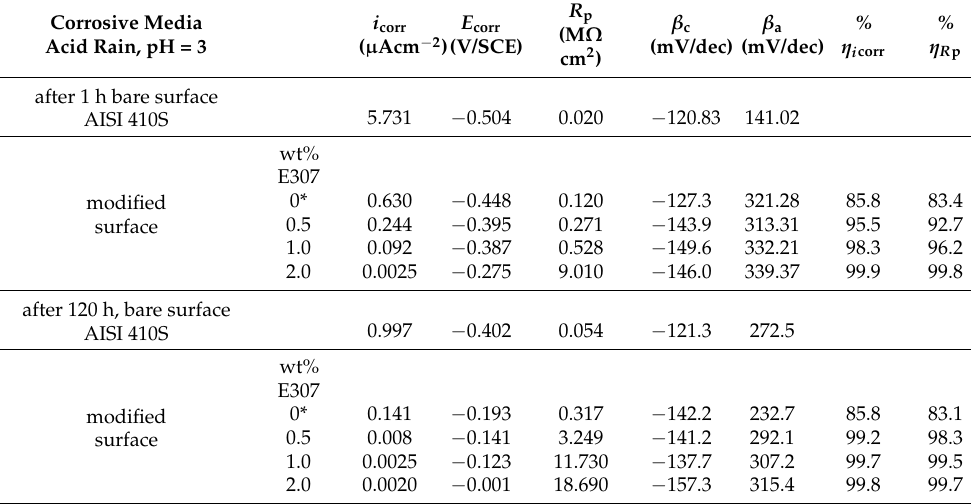
Table 2. Electrochemical impedance parameters (EIS fitting results) for SS AISI 410S (for the bare and modified surfaces) after immersion in simulated solution of acid rain with pH = 3 for different times at 25 °C.